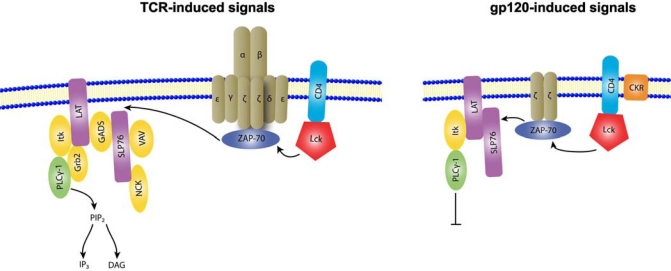
Membrane proximal intracellular signals at the IS versus the HIV VS. The interaction of TCR with its cognate pMHC complex triggers intracellular signaling events that lead to full T cell activation. The TCR proximal signals known to be activated at the IS are shown in the left diagram. Upon TCR engagement, Lck is activated and phosphorylates the TCR ITAMs. ZAP-70 is then recruited to the TCR ITAMs and phosphorylates LAT and SLP76. SLP76 subsequently recruits PLCγ-1 and other signaling molecules including Itk, Grb2, GADS, Nck and Vav. PLCγ-1 cleaves PIP2 to IP3 and DAG; IP3 triggers calcium influx while DAG activates PKCθ and the MAPK/Erk pathway. The signaling propagates downwards to activate transcriptions factors that alter gene transcription such as NF-κB and NFAT. The interaction of CD4 T cells with HIV-1 gp120 also triggers activation of some components of the TCR signaling machinery. The membrane proximal signals currently known to be activated at the VS in the planar bilayer experiments are shown in the right diagram.